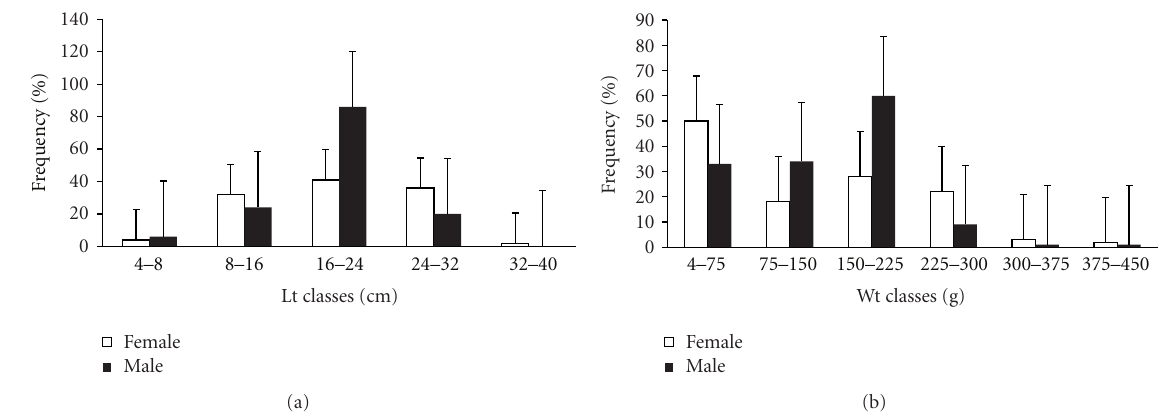
Figure 1: Monthly distribution of frequencies of males and females by total length (a) total weight and (b) with standard deviations.